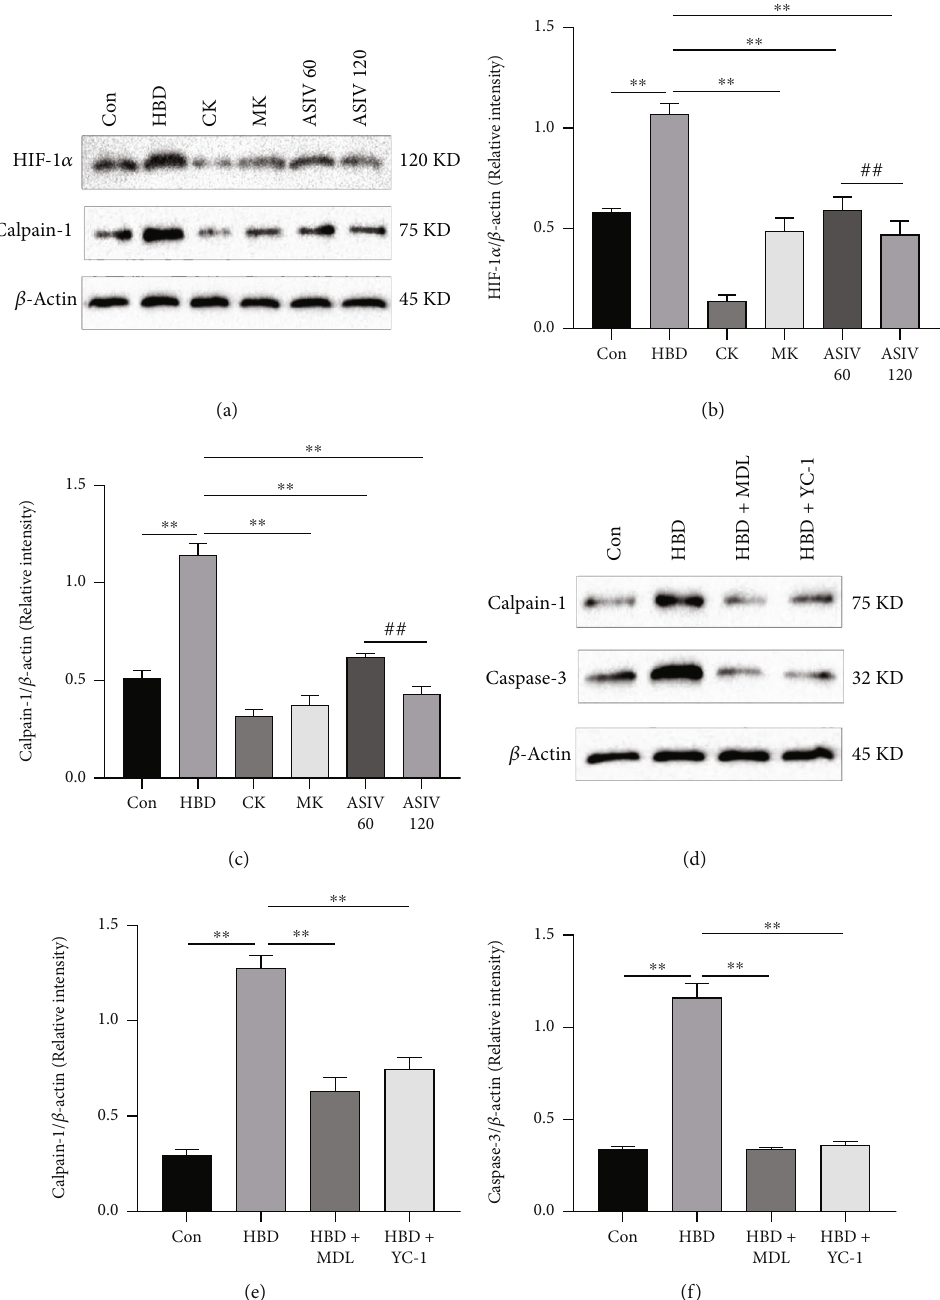
Figure 5: AS-IV and calpain-1 knockout inhibit hypoxia-induced activation of the calpain-1/HIF-1 α /caspase-3 pathway in mouse hippocampal neurons. (a – c) Western blotting was used to detect calpain-1 and HIF-1 α protein expression ( n = 3 ; calpain-1, F ð 5,12 Þ = 201 : 609 ; HIF-1 α , F = 103 : 832 ). (d – f) After YC-1 was introduced, the protein expression of calpain-1 and caspase-3 was detected by ð 5,12 Þ Western blotting ( n = 3 ; calpain-1, F ð 3,8 Þ = 180 : 664 ; caspase-3, F ð 3,8 Þ = 351 : 612 ). Data are presented as the mean ± SD . ∗∗ P < 0 : 01 compared with the HBD group, ## P < 0 : 01 compared with the ASIV 60mg/kg